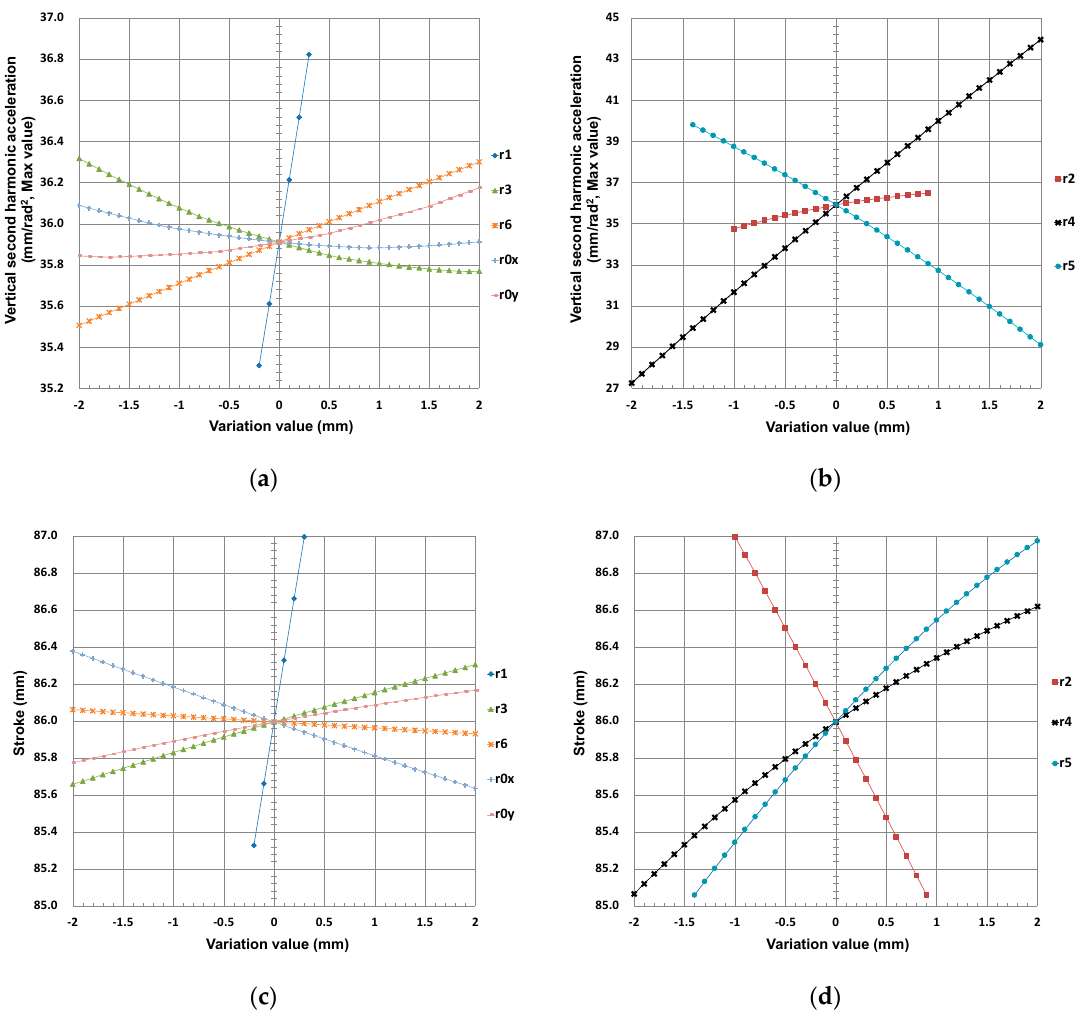
Figure 7. Influence on the maximum of vertical second harmonic acceleration sum of length change in: ( a ) r 1 , r 3 , r 6 , r 0 x , and r 0 y and ( b ) r 2 , r 4 , and r 5 of the ternary link; influence on the stroke of length